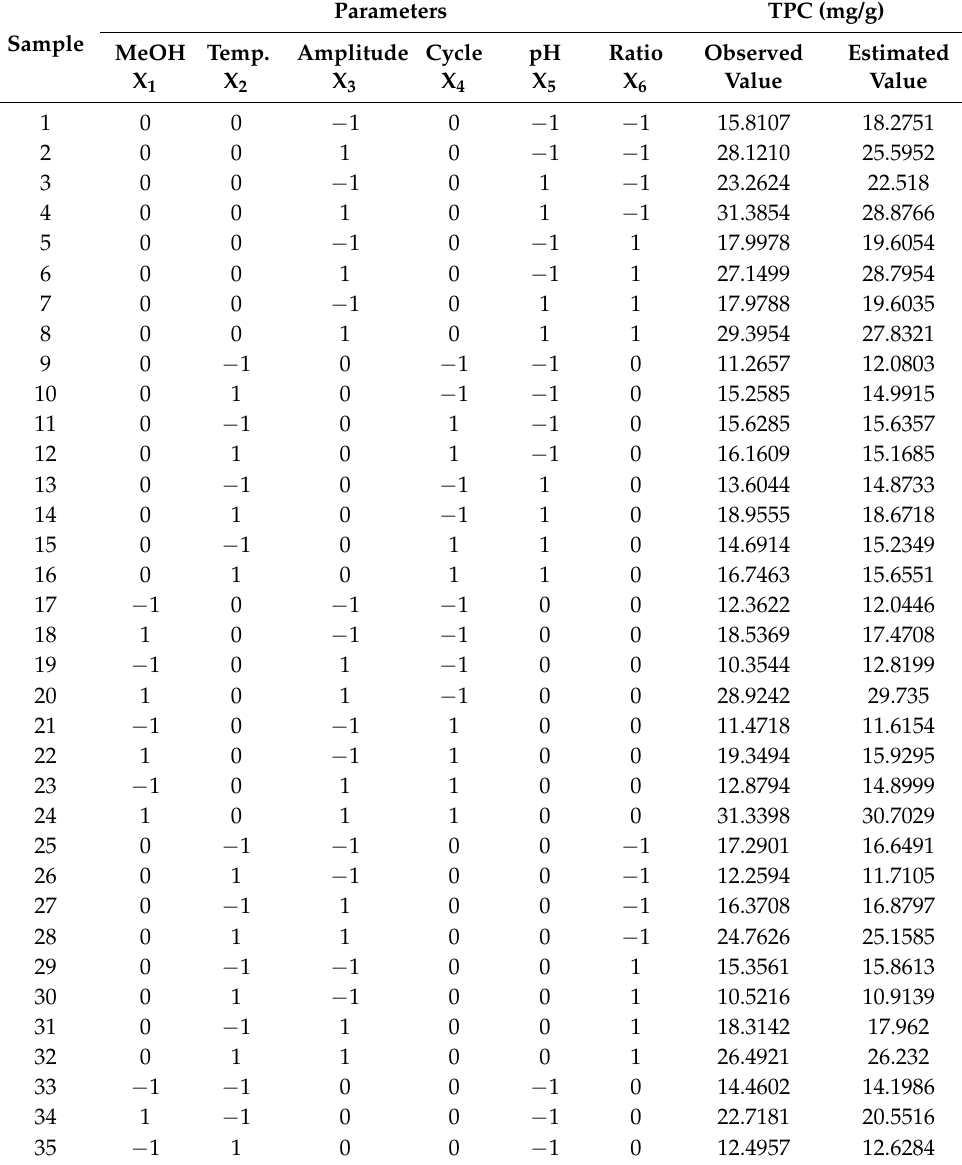
Table 2. Ultrasound-assisted extraction (UAE) of the total phenolic compounds in Santolina chamaecy- parissus according to a Box-Behnken